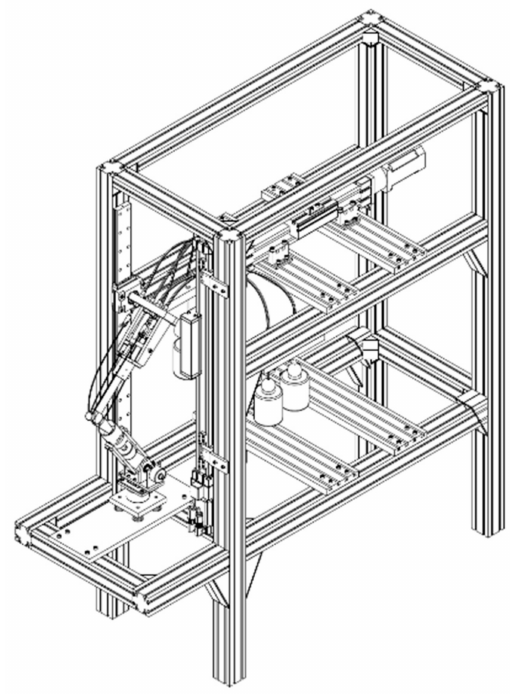
Figure 3. Experimental setup of the established Munich Knee